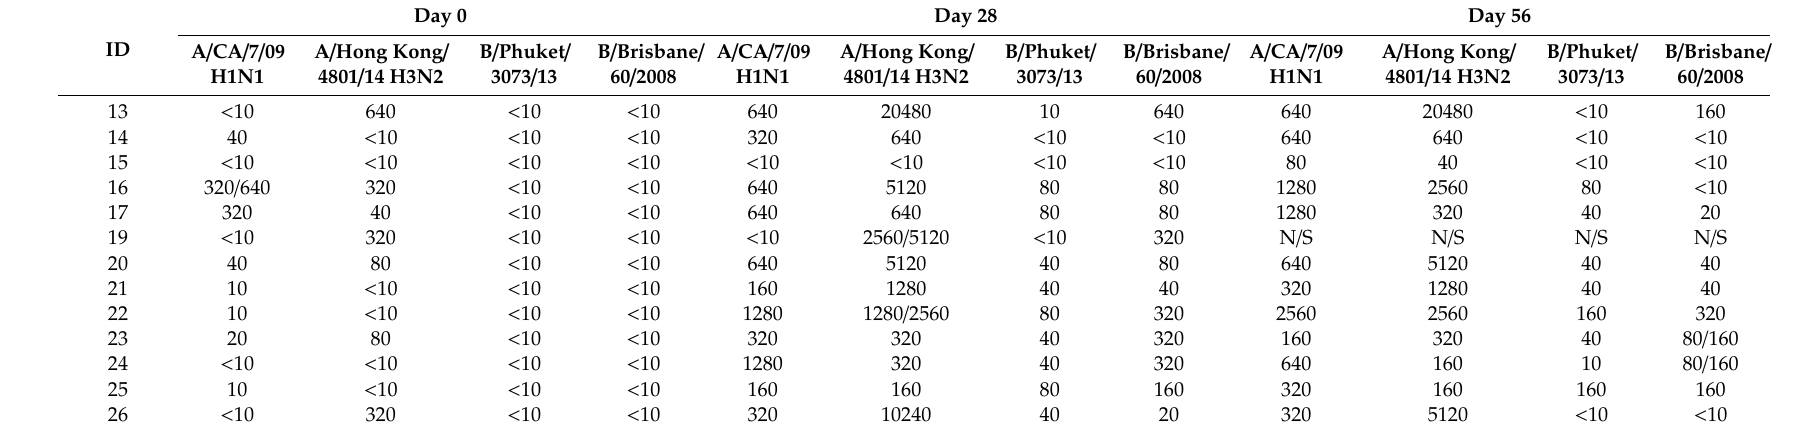
Table A5. HAI results Season